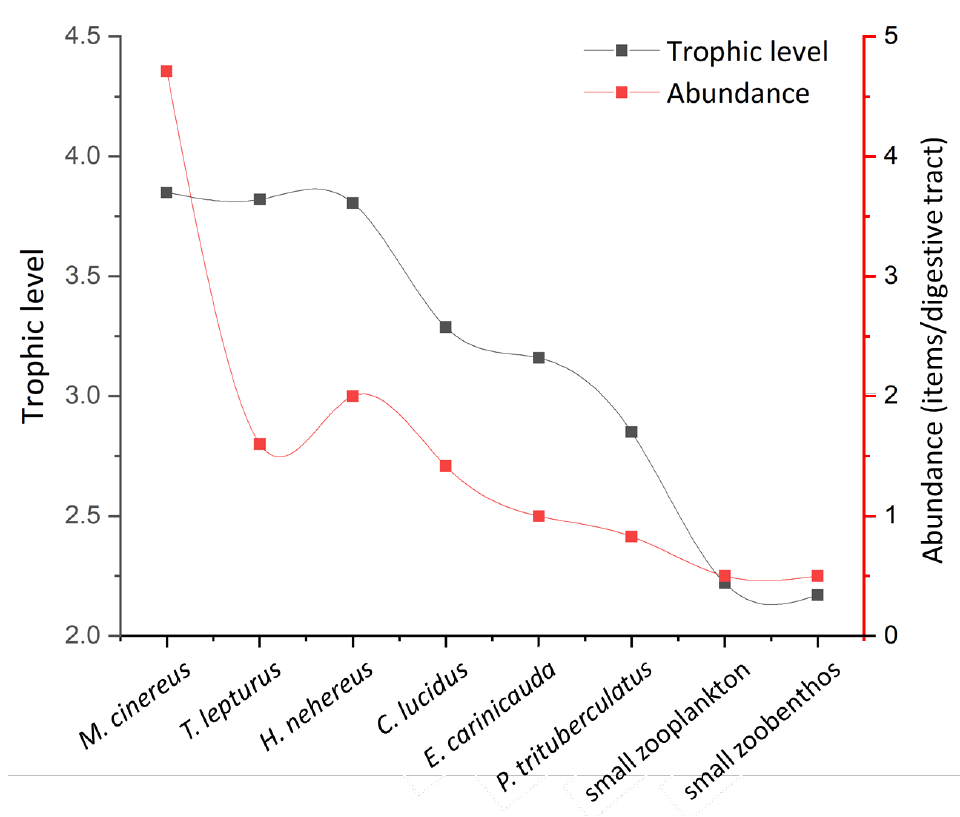
Figure 4. Relationship between trophic level and microplastic abundance (quantified as items/di- gestive tract) (correlation coefficient: 0.717; p <